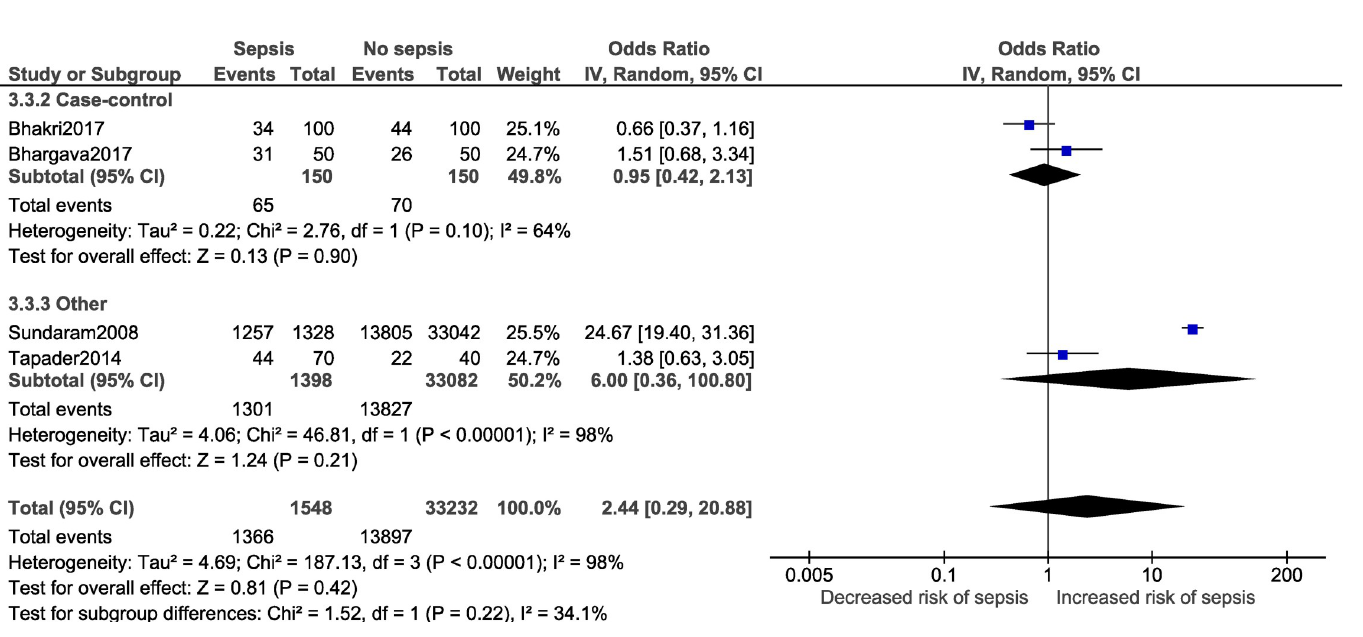
Fig 13. Forest plot showing random-effects meta-analysis for low birth weight ( < 2500 grams) neonates with and without sepsis, sub-grouped by study design (4 studies) [IV: Inverse Variance; CI: Confidence Interval].